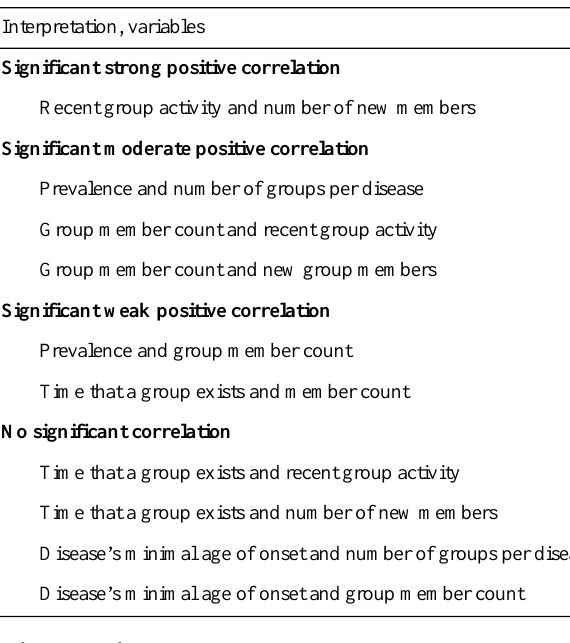
Table 3. Spearman correlations between disease- and group-describing